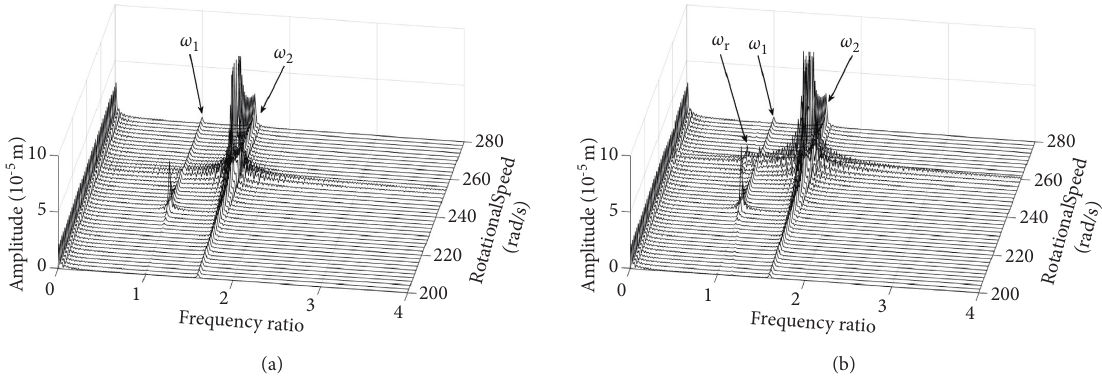
Figure 13: Waterfall spectrum plots for the lateral vibration of disk 4 during hovering flight. (a) Without rub-impact. (b) Rub-impact.